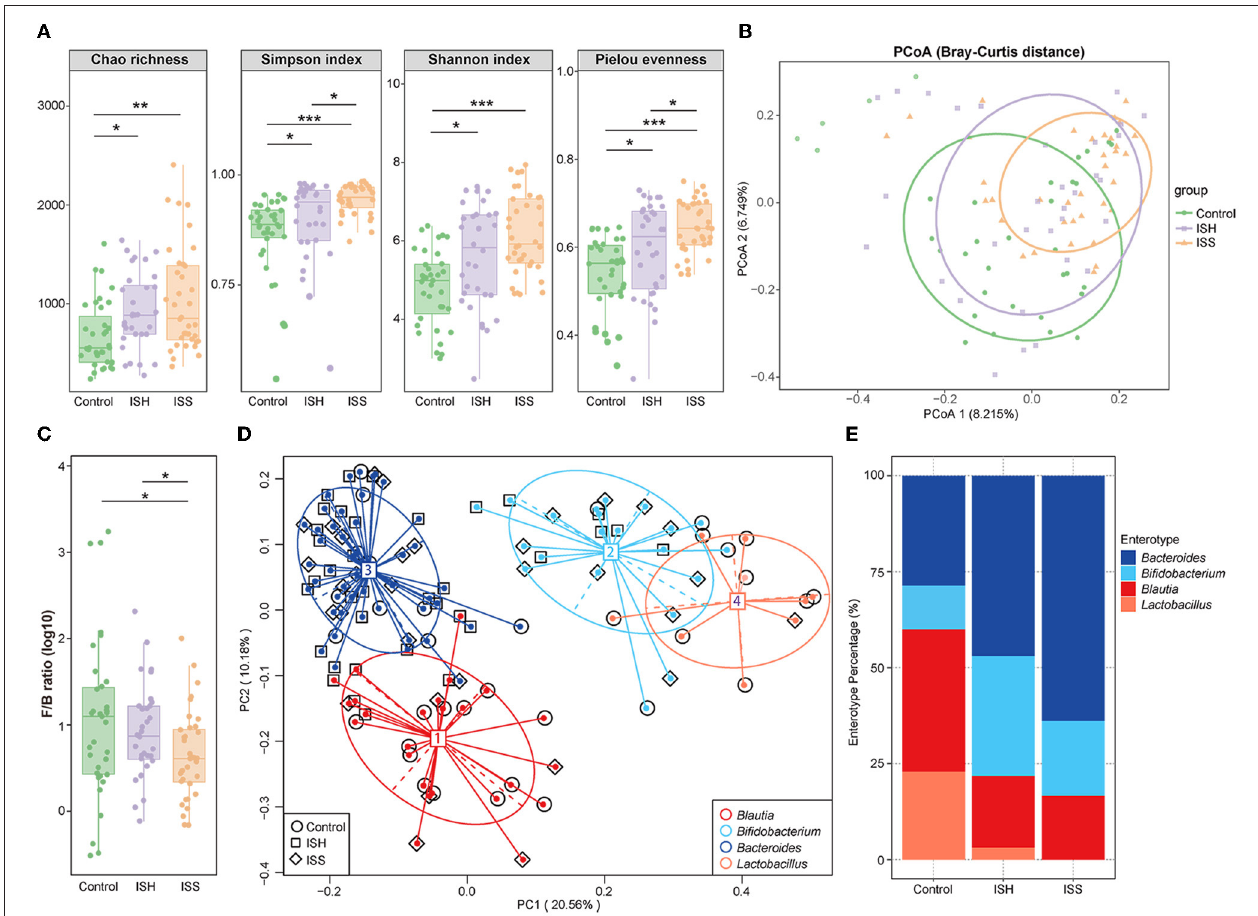
FIGURE 1 | Altered gut microbial diversity and enterotypes in CAD patients with ISH and ISS. (A) Within-individual (alpha) diversity includes Chao richness, Simpson index, Shannon index, and Pielou evenness based on the genera profile in the control, ISH, and ISS groups. (B) PCoA of beta-diversity analysis based on Bray–Curtis distance show separation of the genera in the control, ISH, and ISS groups. (C) The Firmicutes / Bacteroidetes (F/B) ratio in the control, ISS, and ISH patients with CAD. ( P = 0.798, Control vs . ISH; P = 0.036, ISH vs . ISS; P = 0.035, C vs . ISS). (D) A total of 103 samples from the control, ISH, and ISS groups are stratified into four enterotypes by PCoA of Jensen–Shannon divergence at the genera level. The major contributor in the four enterotypes is Blautia , Bifidobacterium , Bacteroides , and Lactobacillus. (E) The percentage of control, ISH, and ISS samples is distributed in the four enterotypes. *, P < 0.05; **, P < 0.01; ***, P < 0.001; n = 35 for the control group, n = 32 for the ISH group, n = 36 for the ISS group; Wilcoxon rank-sum